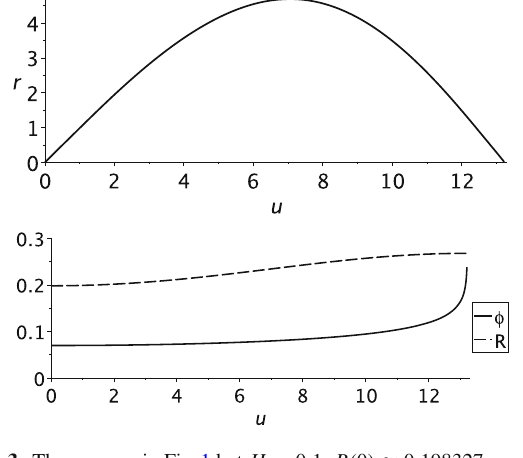
Fig. 3 The same as in Fig.1 but H = 0 . 1 , R ( 0 ) (cid:10) 0 . 198327